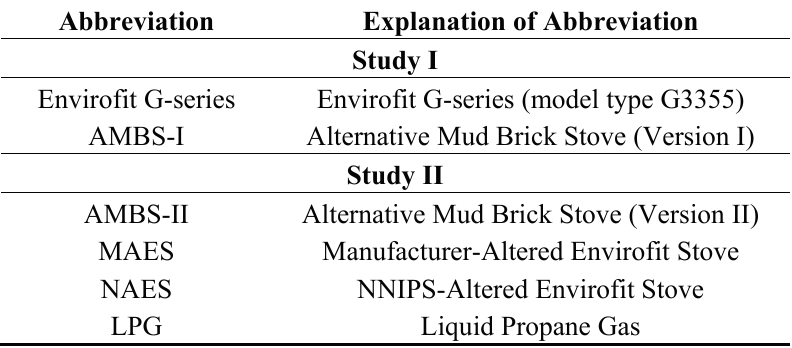
Table 1. Stove Abbreviations for Study I and Study